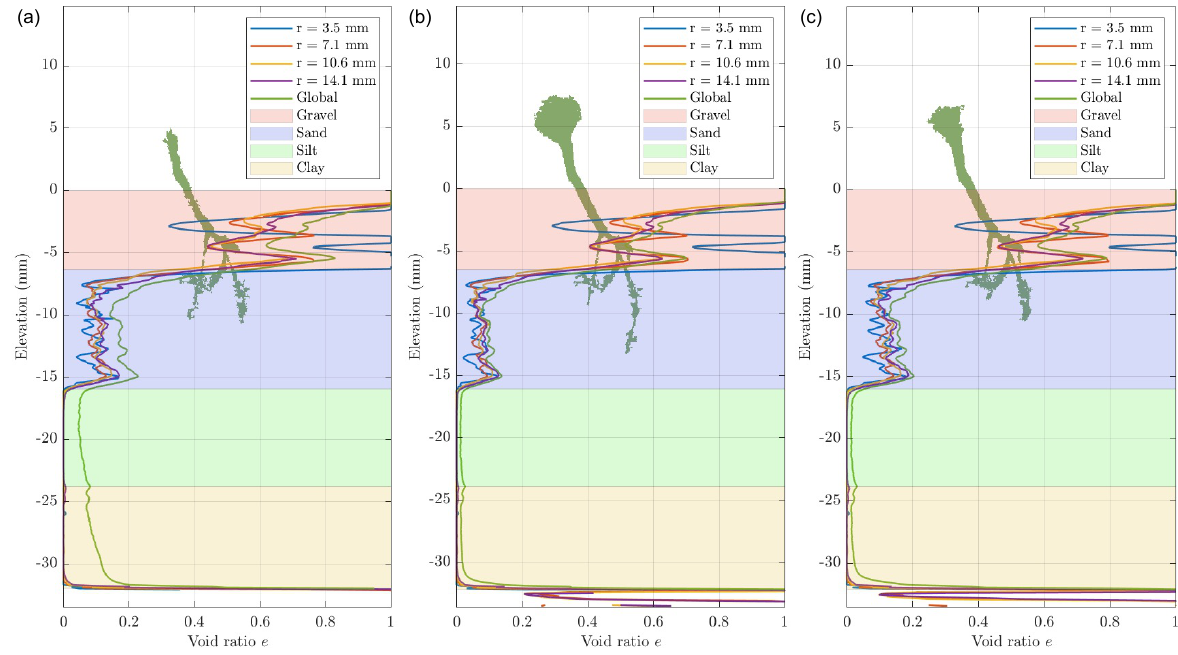
Figure 8. Void ratio profiles with elevation for sample A, day 11 using the classifier trained based on ( a ) 5%, ( b ) 10%, and ( c ) 20% of the image stacks (the layer thickness corresponds to averaged elevation for each